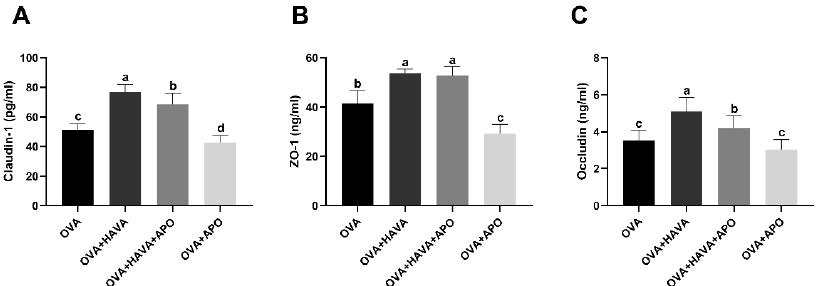
Figure 8. The concentrations of tight junction proteins of jejunum in experiment 2. ( A – C ) The concentrations of Claudin-1, ZO-1, and Occludin in the jejunum. OVA: mice orally challenged with OVA; OVA + HAVA: an OVA-challenged group that was oral gavaged with a high dose of 20 mg/kg bw avenanthramide (AVA); OVA + HAVA + APO: the OVA + HAVA group coupled with apoptozole (APO); OVA + APO: the OVA group coupled with APO. Results are presented as means ± SDs ( n = 9). Bars with no letter in common are significantly different, p ≤ 0.05.